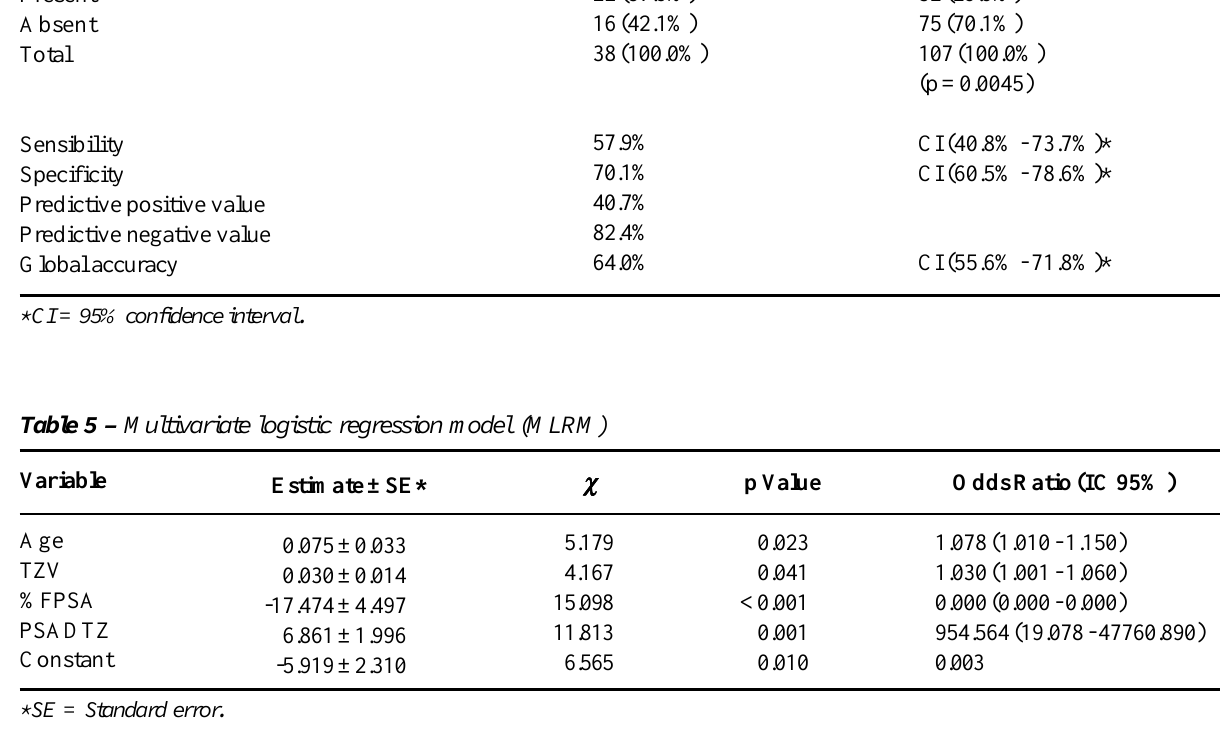
Figure-4 represent the ROC curves produced by MLRM, PSAD, %FPSA, PSADTZ and PSA as well as the area bellow the ROC (global accuracy), their respective trust intervals and the comparison of the different areas in the 95 patients that presented a digital rectal examination without a suspicion of neo-